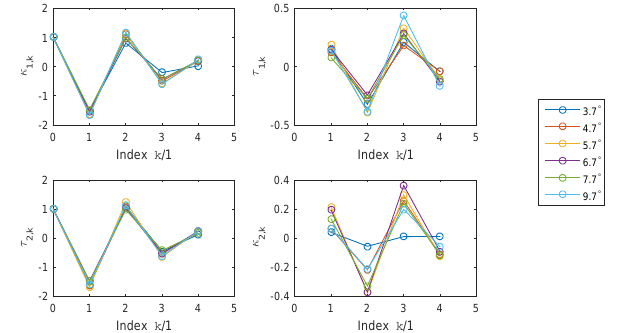
Figure 17. For each elevation angle θ , estimates of the parameters κ 1 ,k (top left), τ 1 ,k (top right), τ 2 ,k (bottom left), and κ 2 ,k (bottom right) defining the AR model in a characterisation of the noise in the two returned signals for different elevation angles. Table 1. For each elevation angle θ , estimates of the elements of (cid:54) defining the AR model in a characterisation of the noise in the two returned